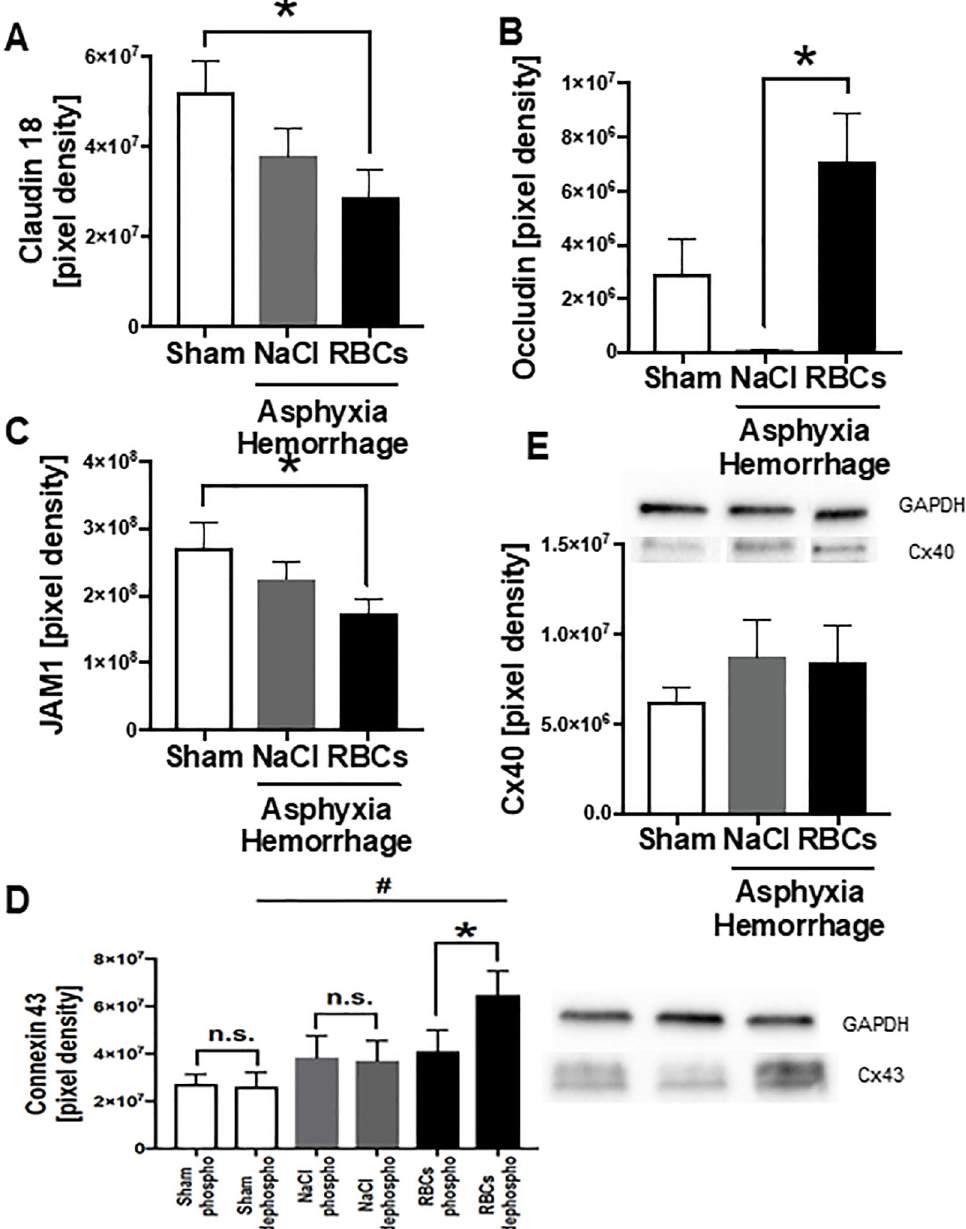
Fig 4. Alterations in cell cell contacts after AH. Results of IHC staining of A) Claudin 18, B) Occludin and C) JAM-1 of lung tissue after asphyxia. Alterations in gap junction protein amount of D) Connexin 43 and E) Protein amount of Connexin 40. � p = 0.05, n.s. = not significant, graphical representation as mean ± SEM, NaCl n = 6, RBC n = 9, sham n = 6.